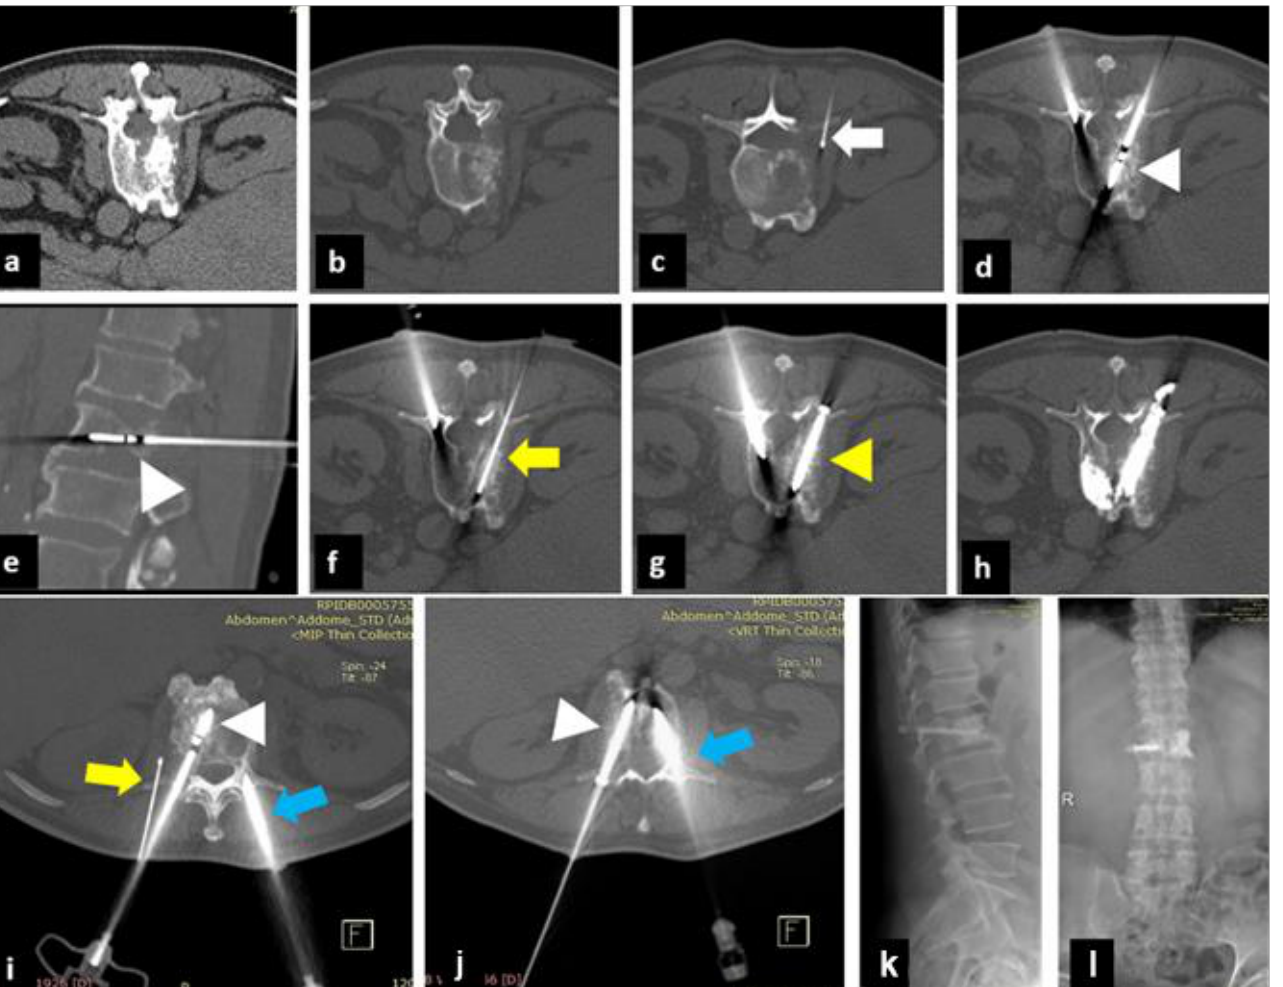
Figure 2. A 65-year-old man with a history of small cell lung carcinoma. ( a , b ): Axial CT shows extensive osteolytic metastasis of the L2 vertebral body involving the right pedicle. ( c ): Axial CT shows thermocouple placement in the left root between L2 and L3 (white arrow). ( d , e ): Axial and sagittal CT, MW antenna placement in the tumor for thermal ablation. Contralateral initial placement of the VTP needle (white arrow). ( f ): Axial CT shows k-wire placement for subsequent coaxial screw insertion (yellow arrow). ( g ): Axial CT shows placement of the left screw (yellow arrow) and contralateral advancement of the vertebroplasty cannula (blue arrow). ( h ): Axial CT shows cementing of the screw (yellow arrowhead) and contralateral vertebroplasty (blue arrow). ( i,j ): Axial CT with Maximum Intensity Projection (MIP) reconstruction showing the MW antenna (white arrow) and thermocouple (yellow arrow) positioned and the vertebroplasty cannula in contralateral extrapedicular location (blue arrow). ( k , l ): Postoperative 3-month radiograph of the thoracolumbar spine in antero-posterior and latero-lateral projection after microwave ablation of the L2 vertebra combined with pedicle screw fixation followed by vertebroplasty (MASFVA).